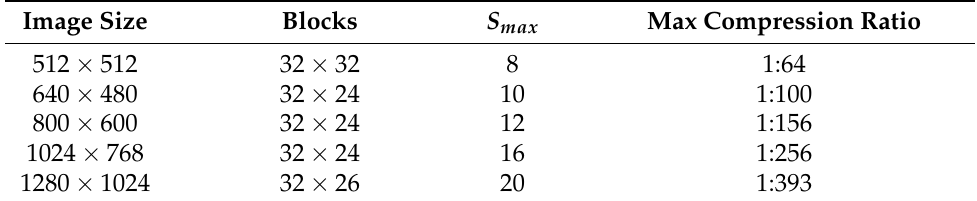
Table 2. S max and Max compression ratio for different image sizes divided into 32 blocks